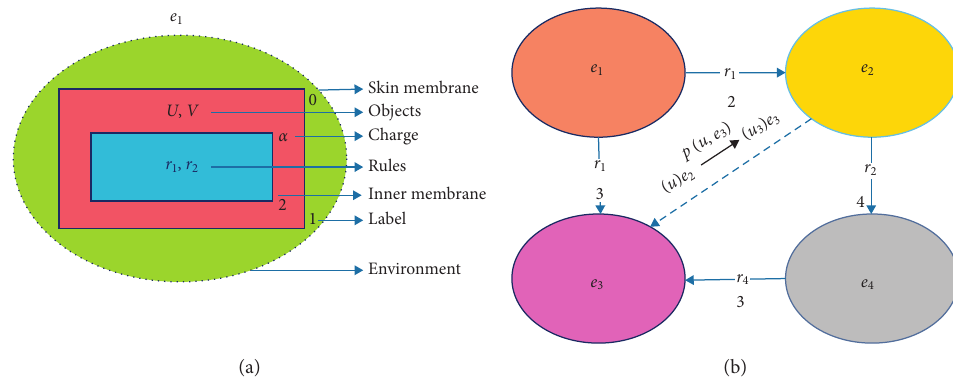
Figure 1: A portion of classified PDP systems used for modelling ecosystems. (a) A single-environment PDP system with two membranes. (b) A multienvironment PDP system with four environments with the same P system skeleton placed inside each environment (their internal structure being omitted). The system shows population activity of the four environments e